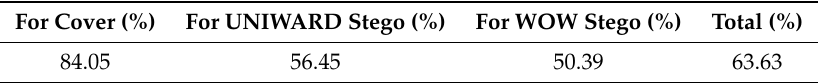
Table 4. Ternary classification rates when simultaneously learning the cover, WOW stego, and